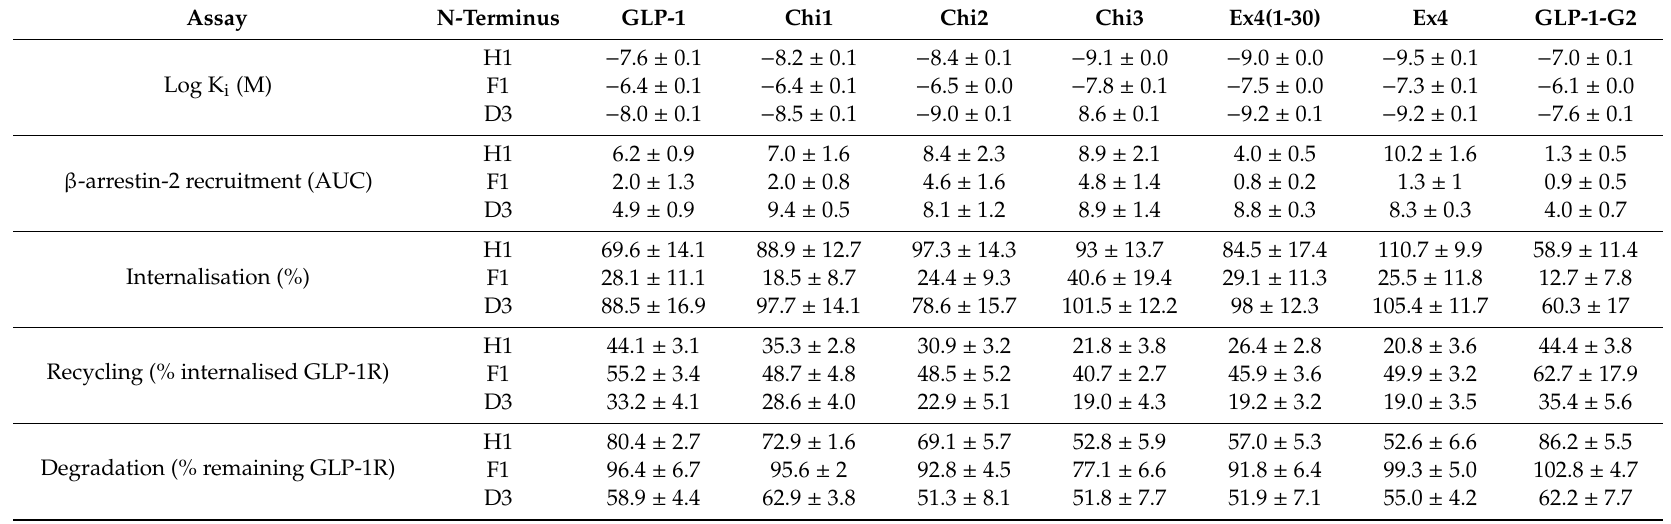
Table 1. Summary of agonist characteristics. Data are represented as mean ± SEM from n = 6 (binding a ffi nity and degradation), n = 5 (internalisation and recycling) or n = 4 ( β -arrestin-2 recruitment) independent experiments.